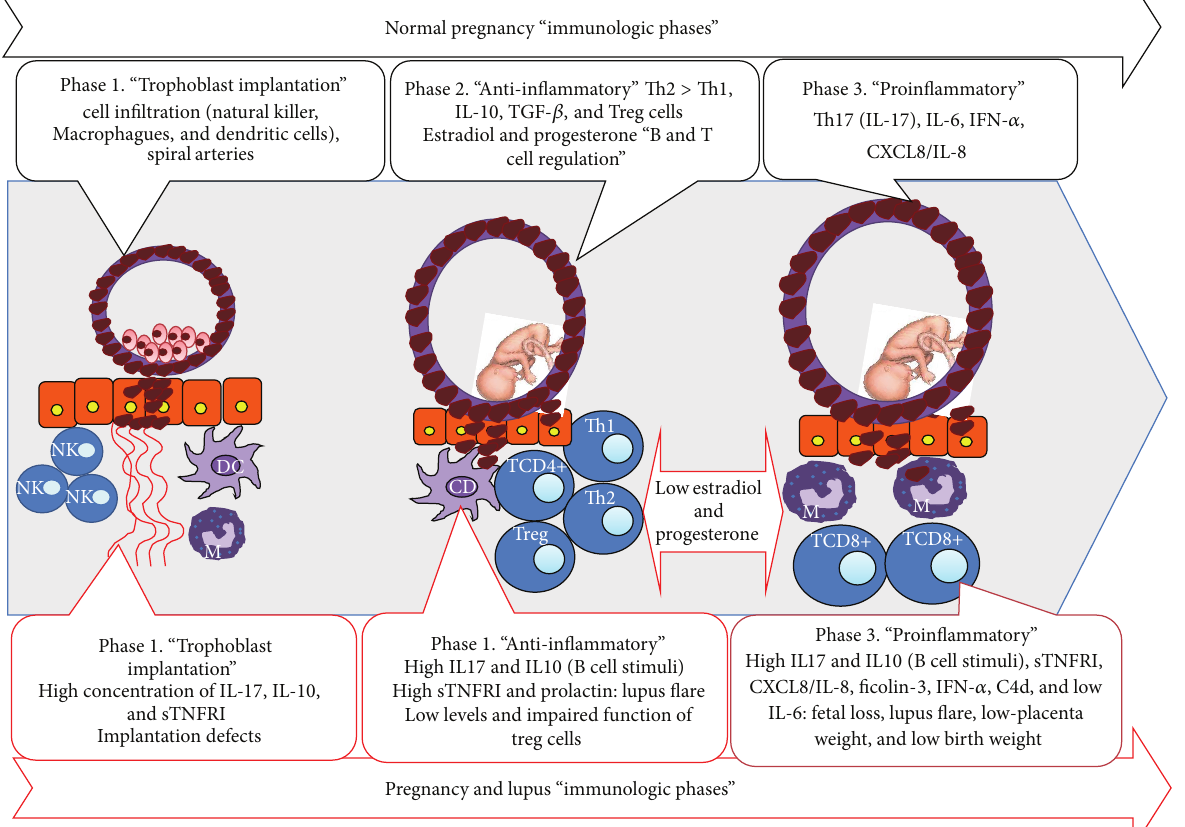
Figure 1: Pathogenesis in normal and SLE